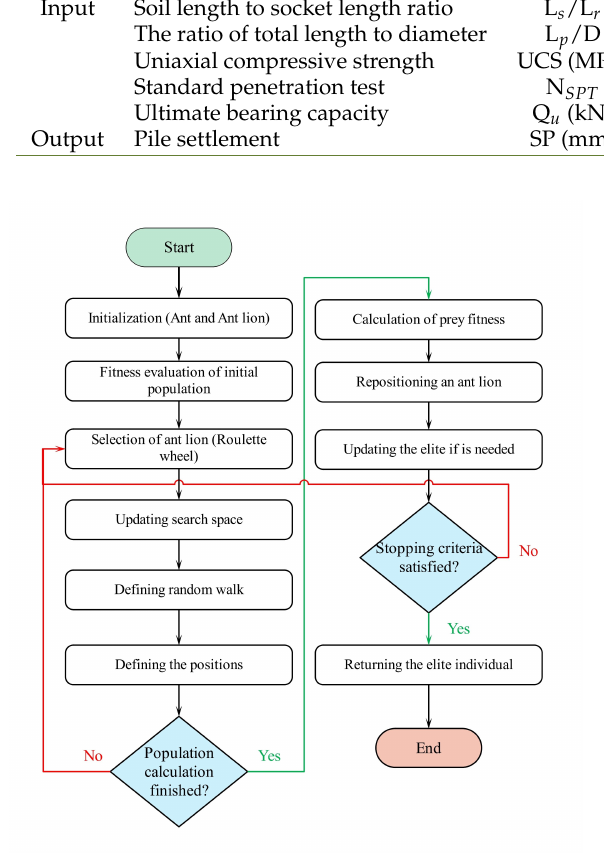
Fig. 3. The flowchart of the ALO